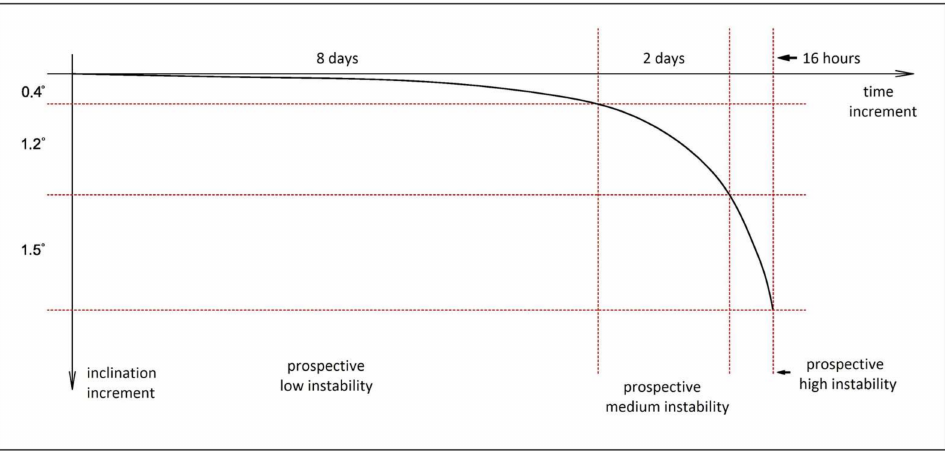
Figure 5. Criterion curve of roof layer destabilization